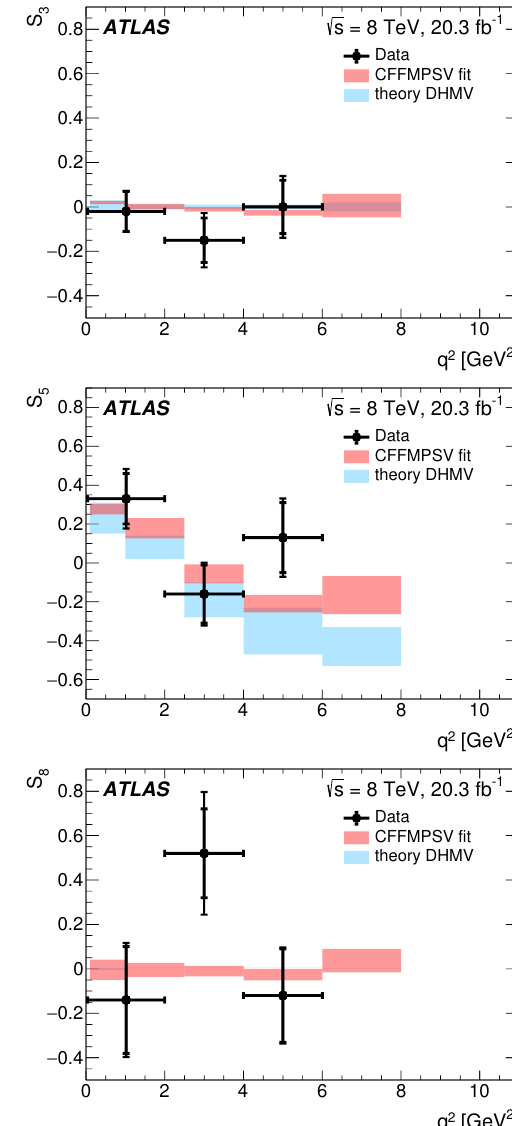
Figure 10 . The measured values of F theoretical calculations discussed in the text (section 8). Statistical and total uncertainties are shown for the data, i.e. the inner mark indicates the statistical uncertainty and the total error bar the total